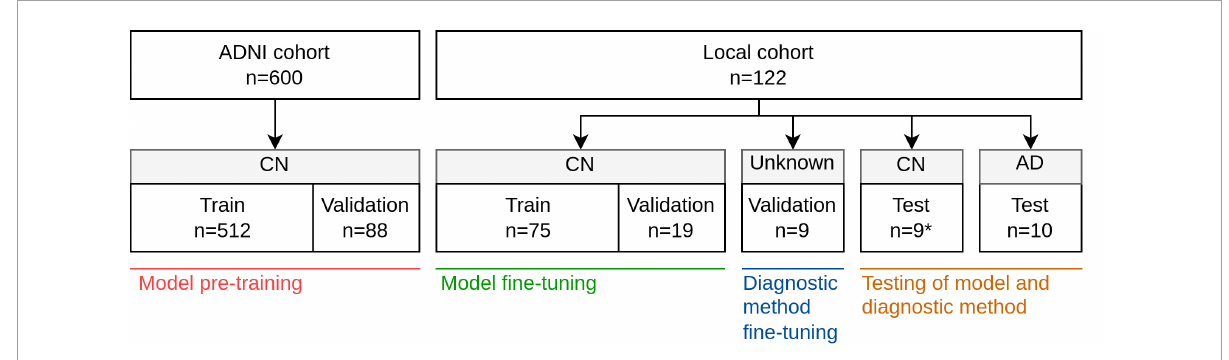
FIGURE1 Overview of cohorts, groups, and data splits and in which of the four stages of development these were used; model pre-training, model fine-tuning, diagnostic method fine-tuning, and testing. *One subject was removed from the original 10 CN test subjects due to presence of pre symptomatic